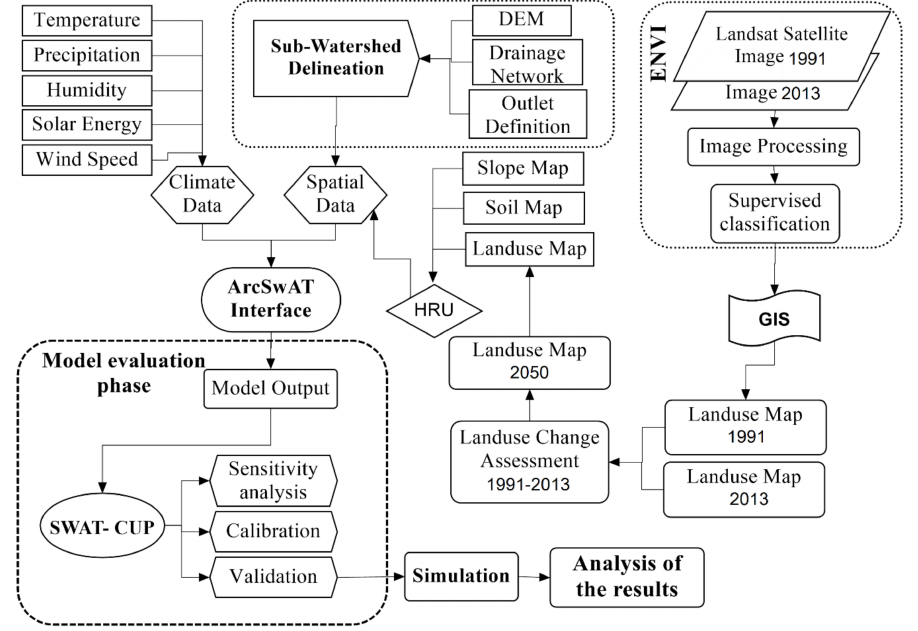
Figure 3. Flowchart for creation of land use scenarios and SWAT